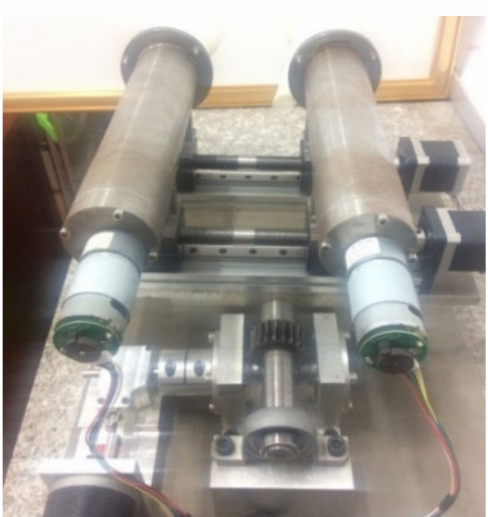
Figure 5. Fixed device.